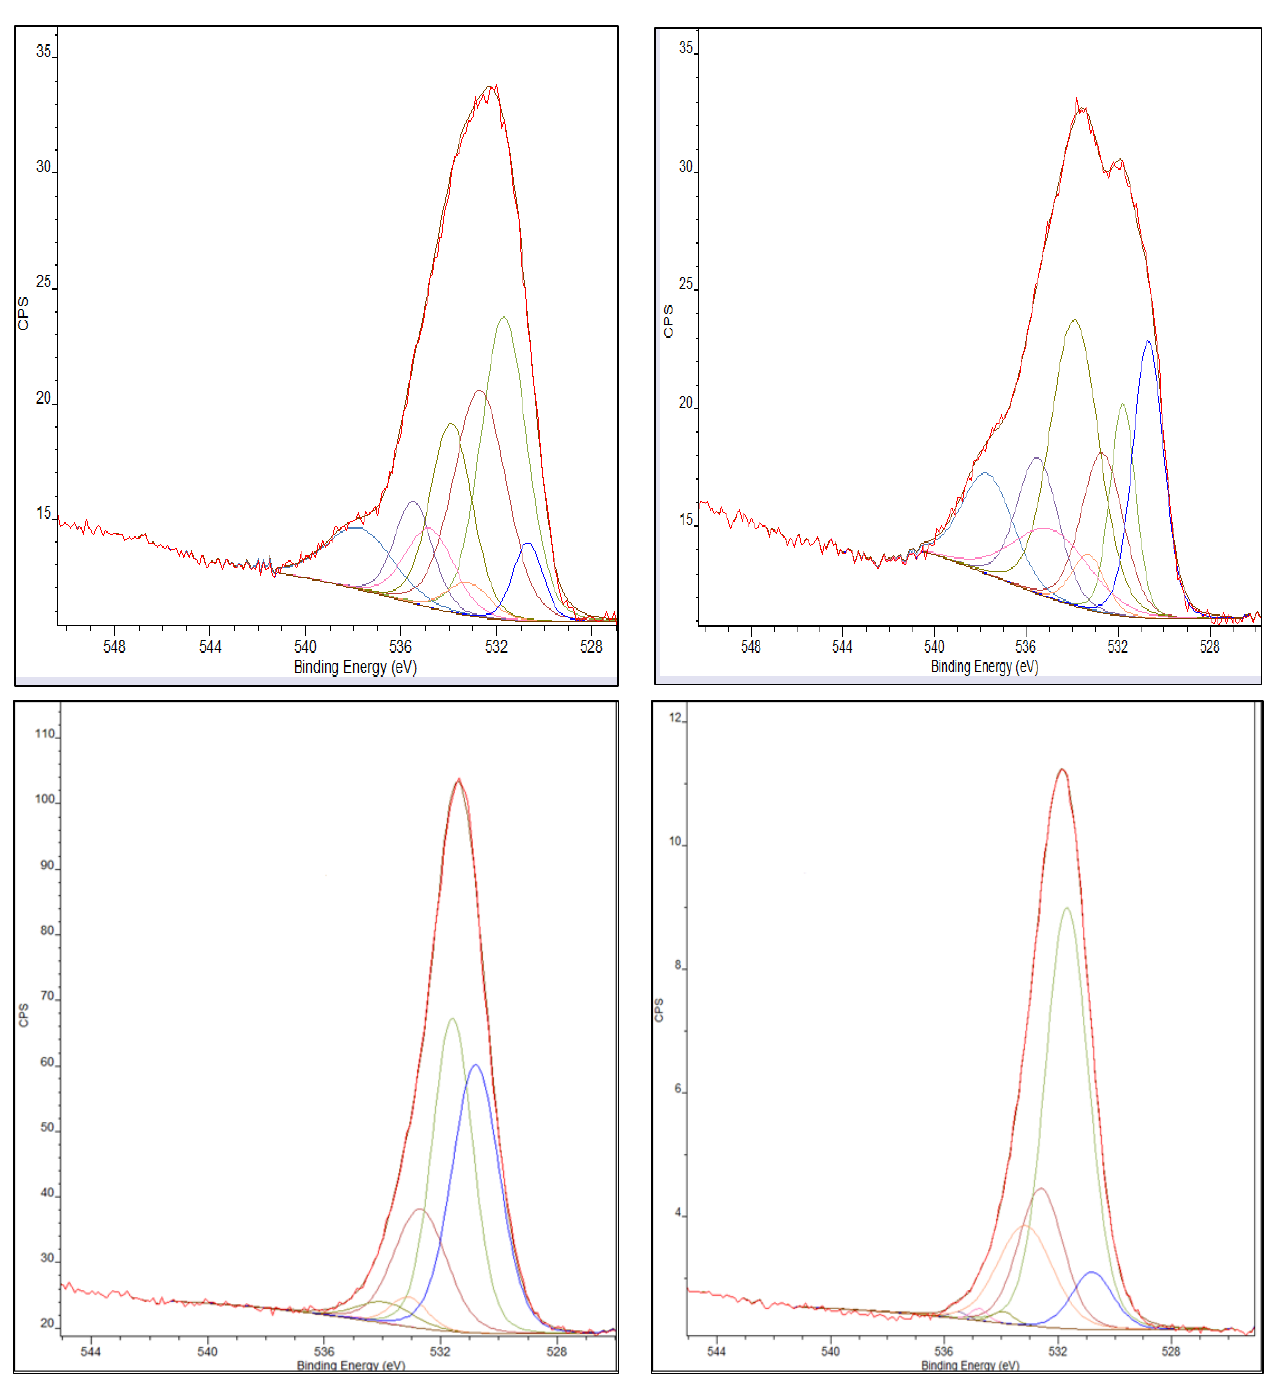
Figure 6. ( Top Left ) O1s deconvolution of standard AC pre-exposure to chromium (VI). ( Bottom Left ) O1s deconvolution of standard AC post-exposure to chromium (VI). ( Top Right ) O1s deconvolution of thermally-treated AC pre-exposure to chromium (VI). ( Bottom Right ) O1s deconvolution of thermally-treated AC post-exposure to chromium (VI).